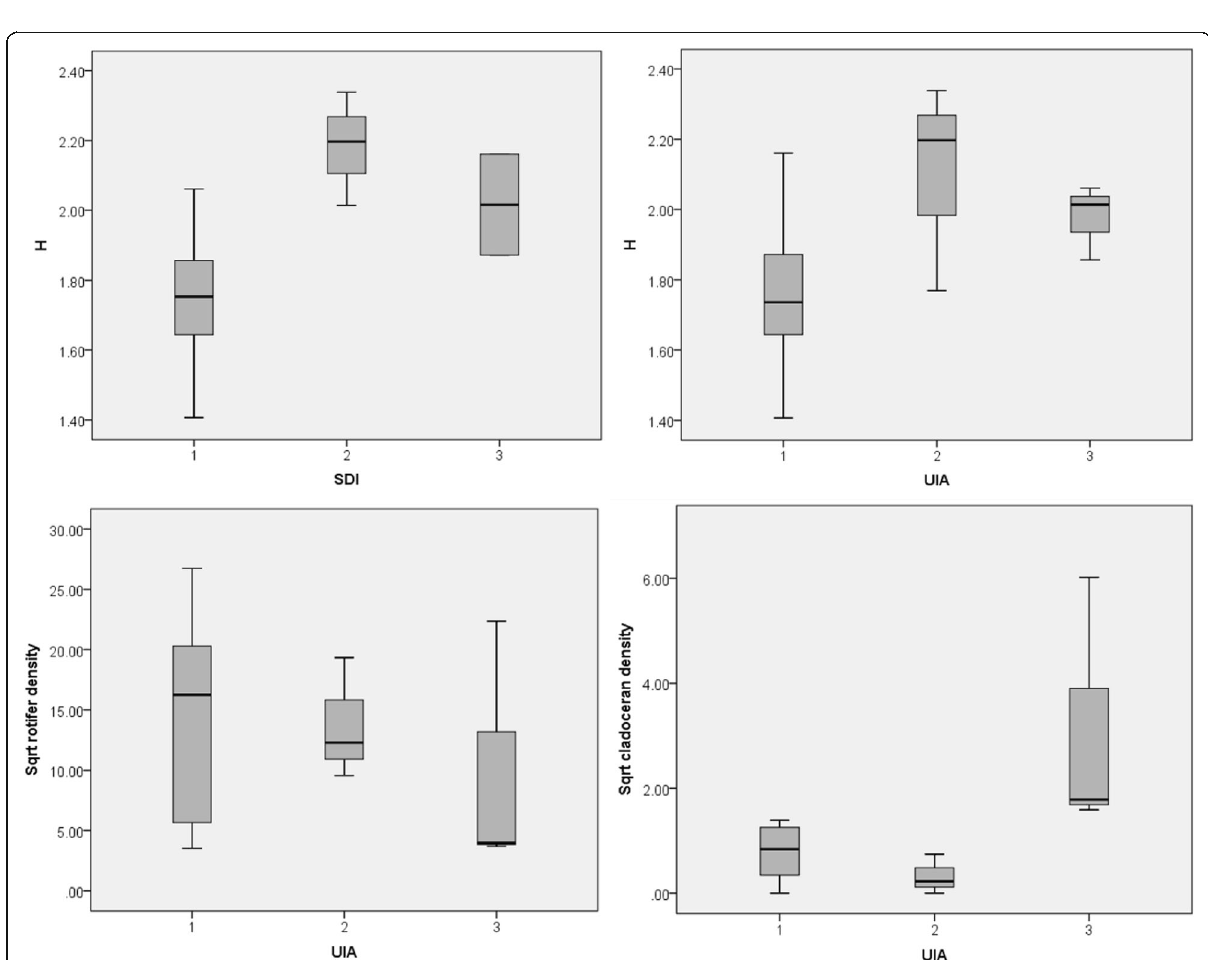
Fig. 7 Abundance and diversity against urbanization gradients. Numbers: 1 = high-density development, 2 = medium density development, and 3 = low-density